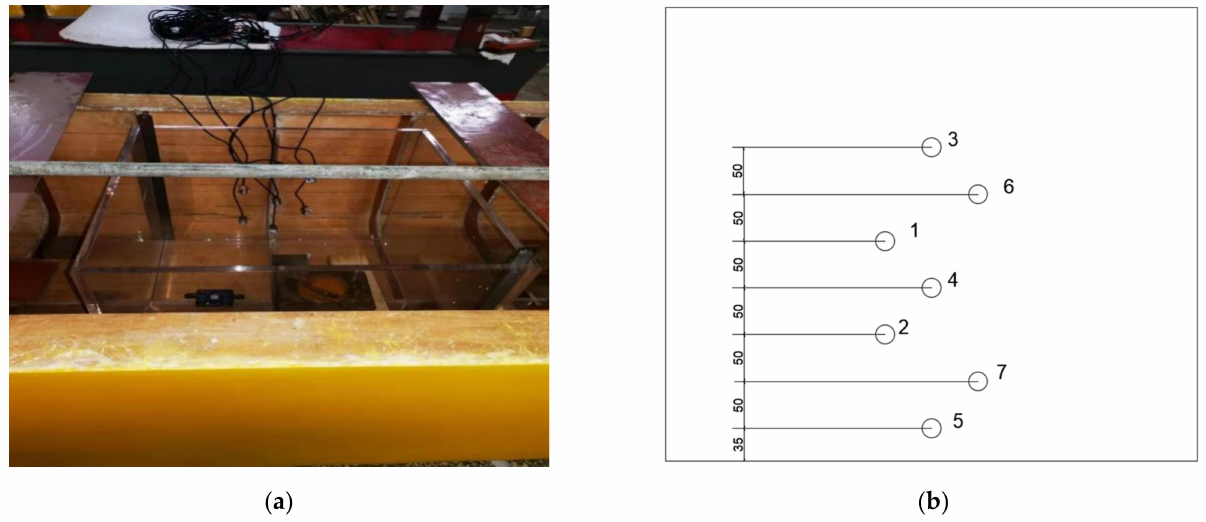
Figure 3. The layout of the pressure sensor for the side bulkhead of the tank ( a ) The pressure sensor and the tank; ( b ) The layout of the pressure